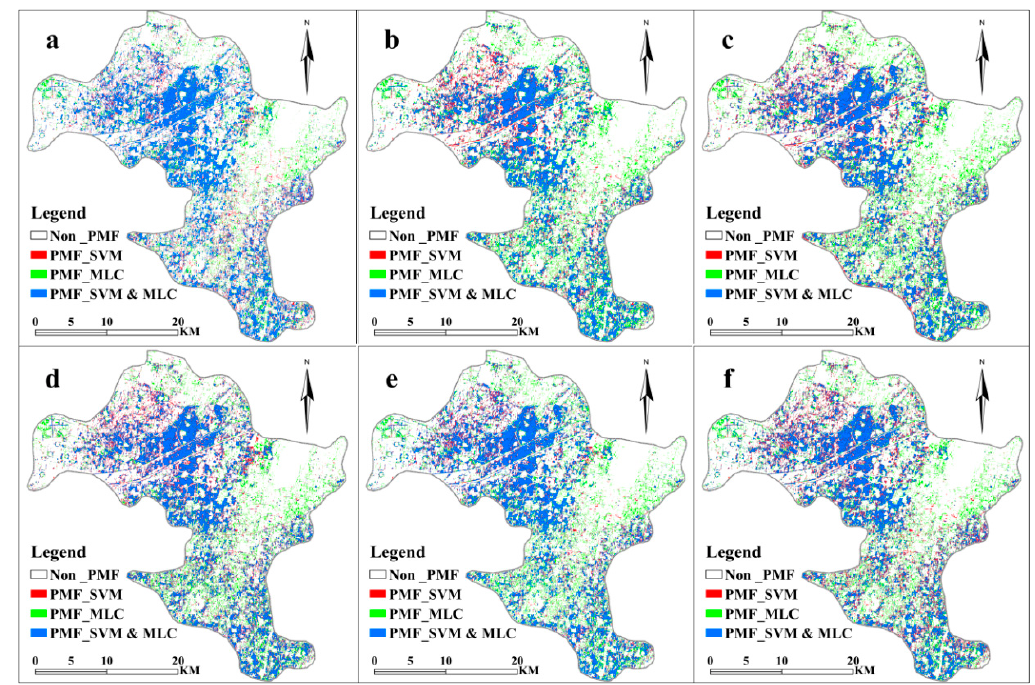
Figure 4. The spatial distribution of the plastic-mulched farmland extracted from different classifiers using different feature sets (Non_PMF: Non plastic-mulched farmland area; PMF_SVM: plastic-mulched farmland extracted from SVM-L alone and not from MLC; PMF_MLC: plastic-mulched farmland extracted from MLC alone and not from SVM-L; PMF_SVM & MLC: plastic-mulched farmland extracted from both SVM-L and MLC): ( a ) results of spectral features; ( b ) results of combined spectral features and 0° directional textural features; ( c ) results of combined spectral features and 45° directional textural features; ( d ) results of combined spectral features and 90° directional textural features; ( e ) results of combined spectral features and 135° directional textural features; and ( f ) results of combined spectral features and all directional textural features.)